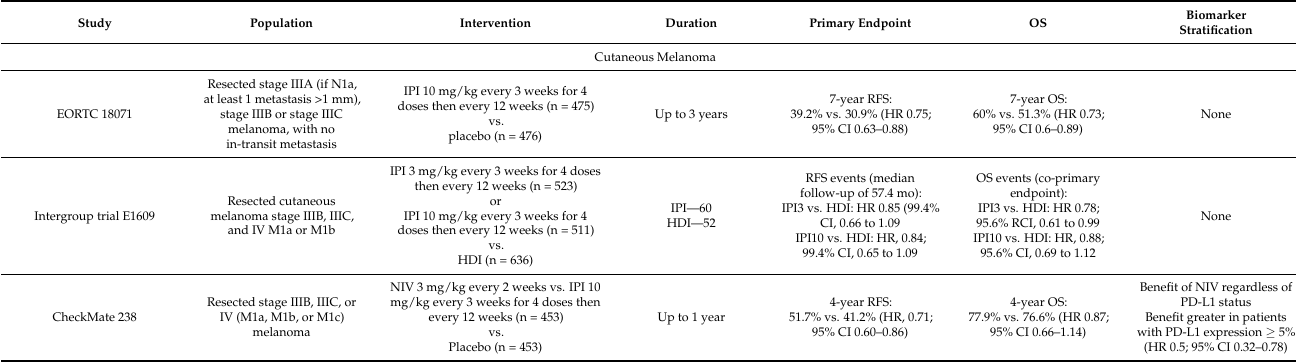
Table 1. Summary of clinical trials of ICIs in the adjuvant